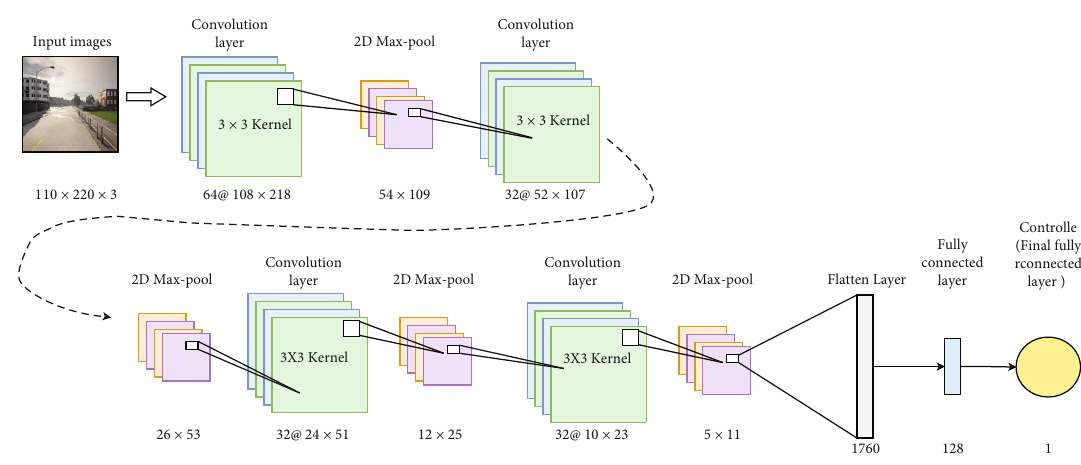
Figure 7: Network architecture.